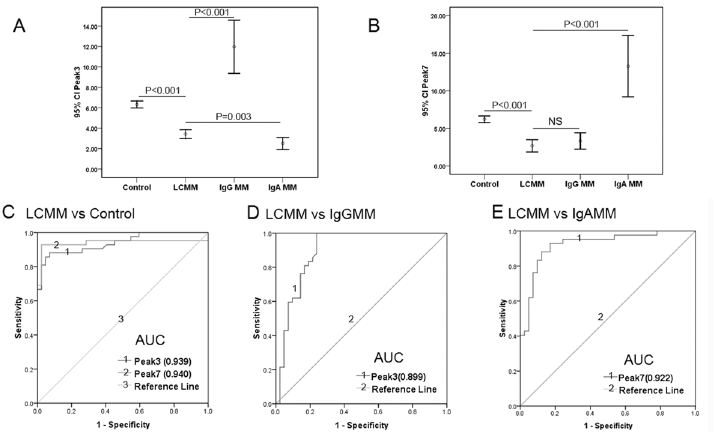
Fig 3. Peak3 and Peak7 could be used as diagnosis and differential diagnosis markers for LCMM. (A and B): showed the changes of two biantennary glycans (NG1A2F, Peak 3; and NA2FB, Peak 7) among 4 groups and error bars represent 95% confidence intervals (95% CI) of the means. Peak3 and Peak7 were decreased in LCMM group compared with the other 3 groups, except that Peak 3 was elevated in patients with LCMM relative to patients with IgA MM. (C): ROC curves for Peak 3 and Peak7 in patients with LCMM versus healthy controls with the area under the curve (AUC) of 0.939 and 0.940, respectively. (D): ROC curve for Peak3 in patients with LCMM versus IgG MM and the AUC was 0.899. (E): ROC curve for Peak7 in patients with LCMM versus IgA MM with the AUC of